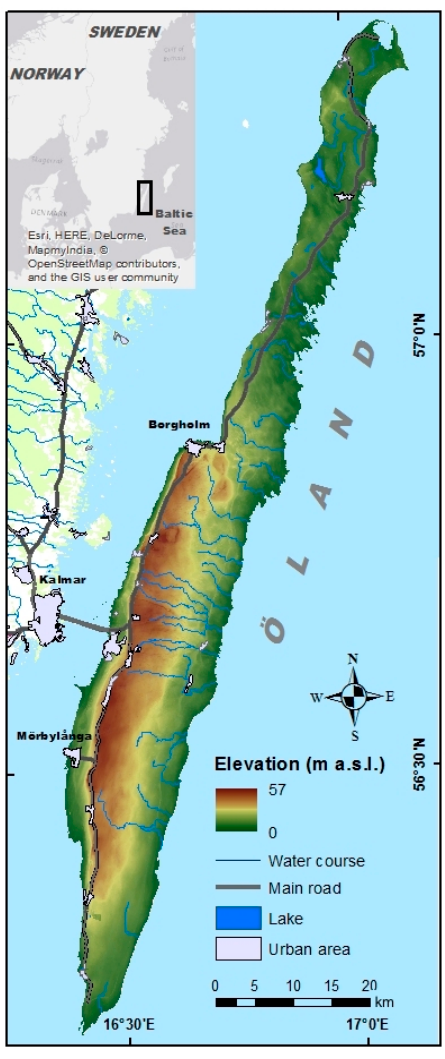
Figure 1. Study area, location in Scandinavia, topography, hydrology, urban areas, and main roads.